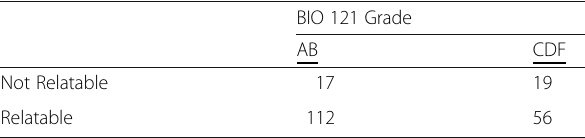
Table 2 Frequencies of students by final course grade and whether students relate to their peer leader